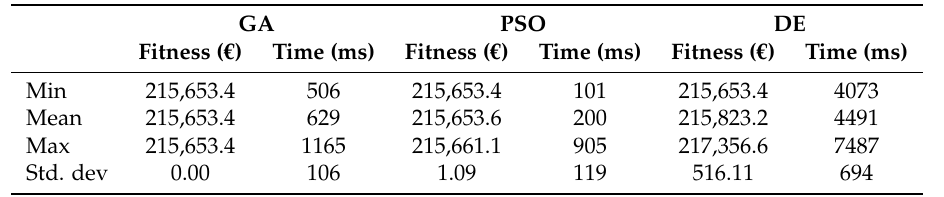
Table 2. Results obtained by the genetic algorithm, particle swarm optimization (PSO) and differential evolution (DE) (50 independent runs).